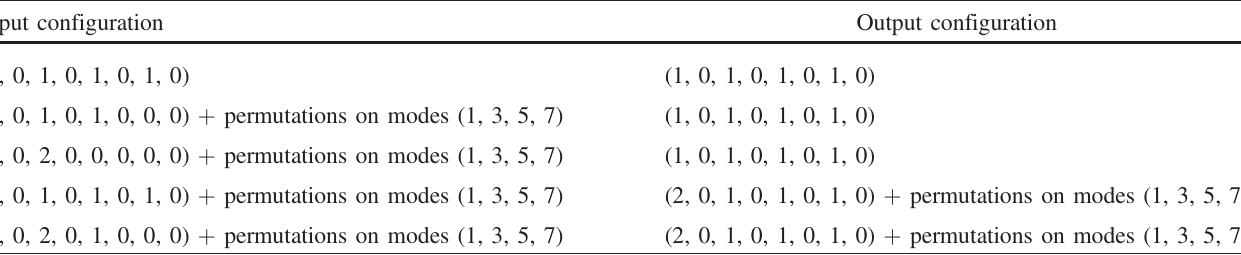
TABLE III. Configurations providing contributions to the input-output probability, in the presence of multiphoton emission and losses, for output modes (1, 3, 5, 7). Analogous tables can be constructed for each set of 4 output modes. Input